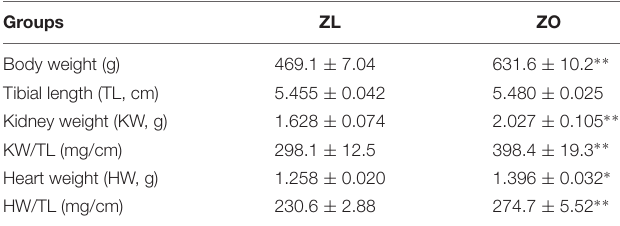
TABLE 1 | Morphological variables in male Zucker lean (ZL) and obese (ZO) rats at 8 months old.